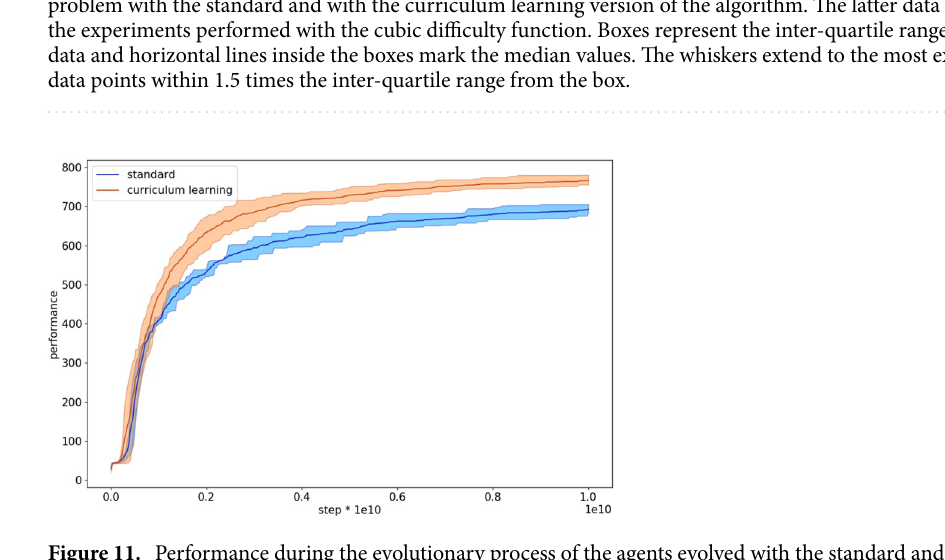
Figure 11. Performance during the evolutionary process of the agents evolved with the standard and with curriculum learning Steady State algorithms on the double pole balancing problem. The latter data refers to the experiments performed with the cubic difficulty function. Each curve shows the average results of 10 replications. The shadow indicate the 90% bootstrapped confidence intervals.